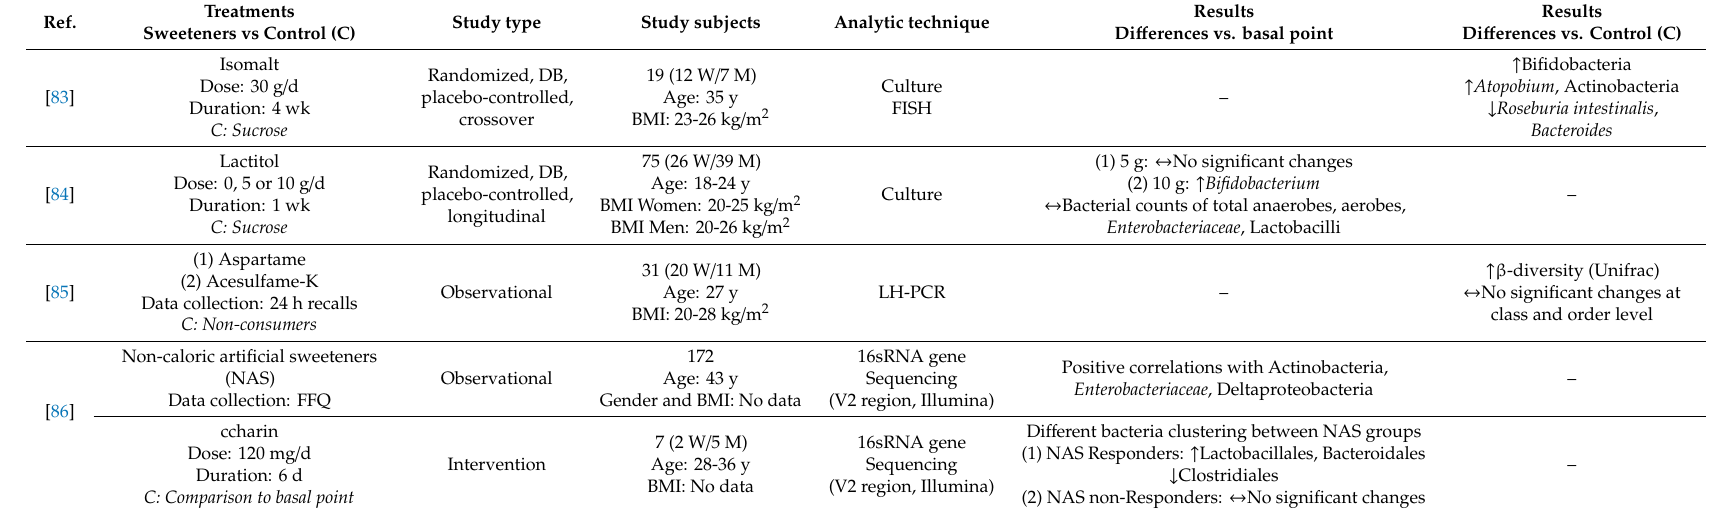
Table 4. Evidence from human studies relative to sweeteners e ff ects on the gut microbiota composition of healthy adults.